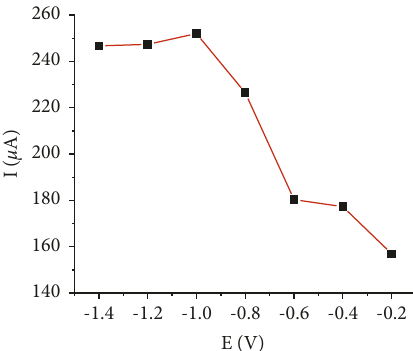
Figure 11: Accumulation potential effect on the voltammetric current of 100nM Cd(II). Supporting electrolyte solution: B-R buffer of pH 4; accumulation time: 270 s; amplitude: 100 mV; frequency: 80Hz; and step potential: